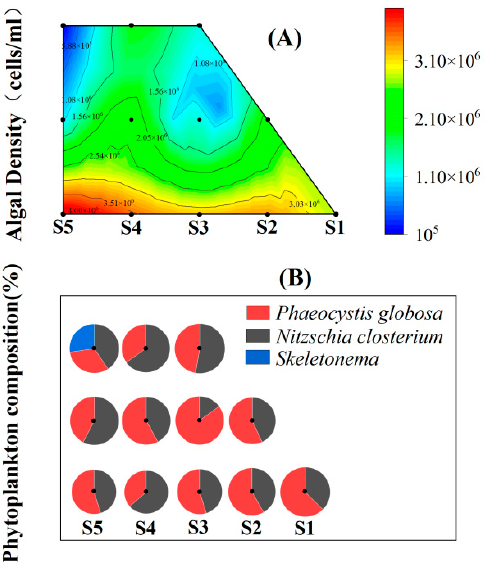
Figure 4. Spatial algal density in the JSB coastal water during spring algal bloom ( A ), and percentage of algae in JSB coastal waters ( B ).